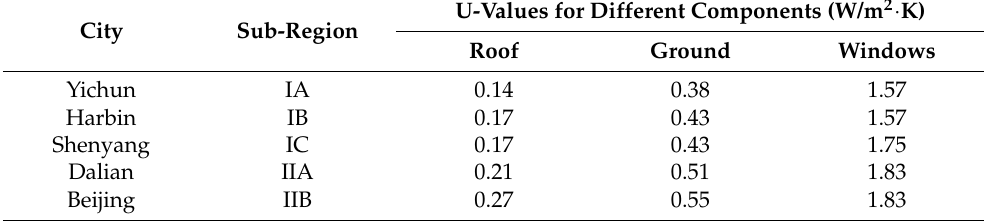
Table 5. U-values of building envelope in the simulation settings.